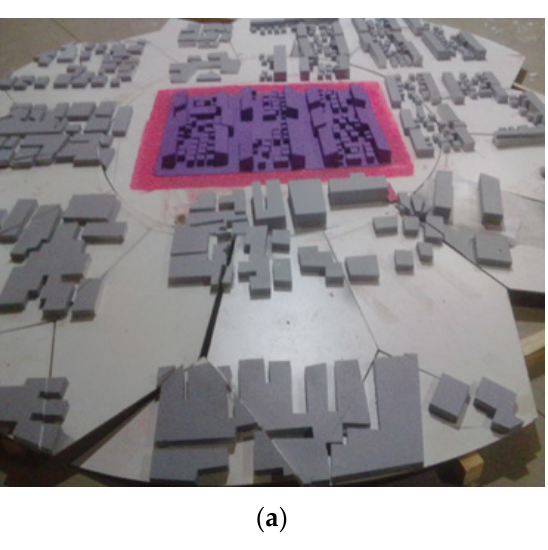
Figure 4. ( a ) Urban area and surroundings model at a geometrical scale of 1/100. The purple area represents the focus urban area to be evaluated by numerical models; ( b ) the IFA 300 hot wire/film under operation mounted in a four-degree positioner.